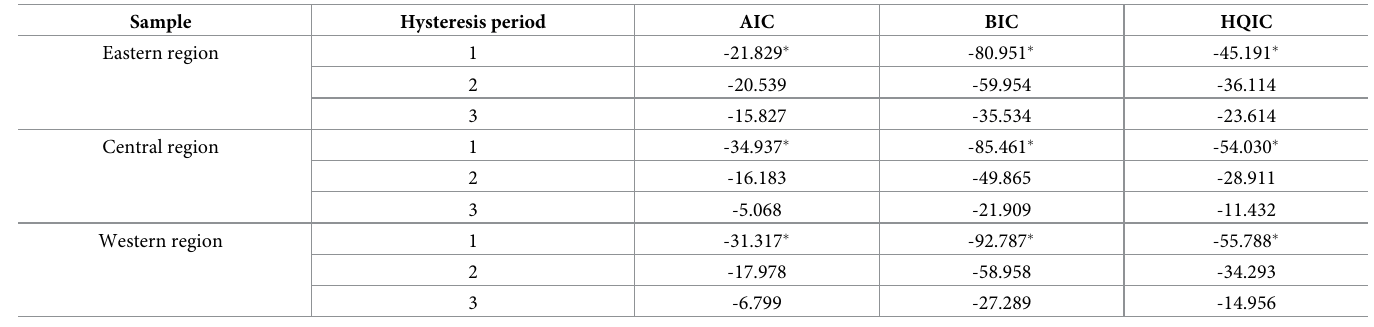
Table 3. Selection of lag order of PVAR model.